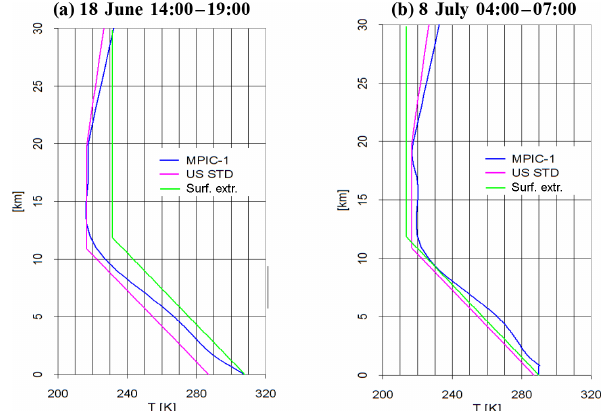
Figure 5. Temperature profiles extracted in different ways for two periods, ( a 18 June, 14:00–19:00 and b 8 July, 04:00–07:00). The blue profiles are extracted from in situ measurements and ECMWF profiles as described in the text. The green profiles are extracted from the surface temperatures and assume a constant lapse rate of − 6 . 5K / km up to 12km and a constant temperature above. The pink curves represent the temperature profile from the US standard atmo-